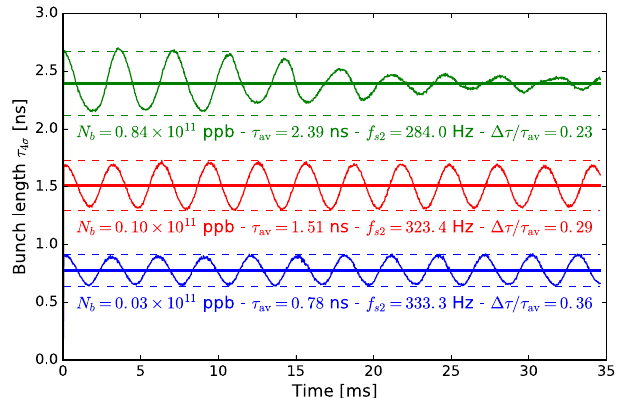
FIG. 2. Examples of bunch length oscillations at SPS injection measured in the Q26 optics for different average bunch lengths τ